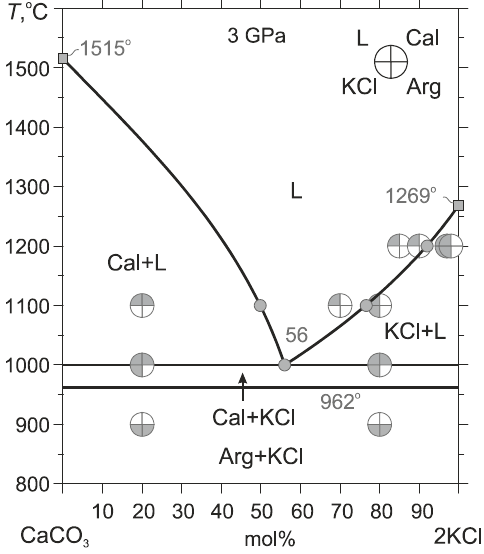
Figure 2. T-X diagram for the system KCl–CaCO 3 at 3 GPa. Large circles denote sample bulk composition, whereas filled segments indicate phases present. Small circles indicate the composition of melt measured by EDS. The uncertainty in the temperature estimate does not exceed the size of the small circles ( ≤ 25 °C). The CaCO 3 and KCl melting points are after [37] and [39], respectively. The obtained results are in reasonable agreement with the melting point of KCl, T m = 1269 °C, established previously by Pistorius [39], and the melting point of CaCO 3 , T m = 1515 °C, determined by Shatskiy et al. [37] (Figure 2).